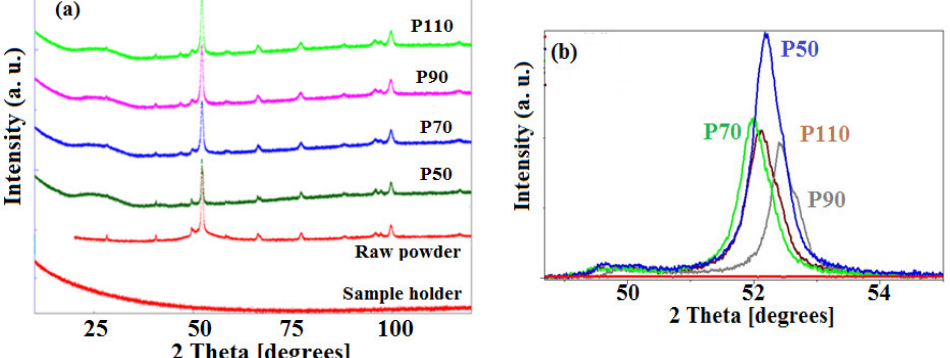
Figure 2. ( a ): XRD patterns of the sample holder, initial powder, and laser melted samples; ( b ): Zoom of the main diffraction peak.